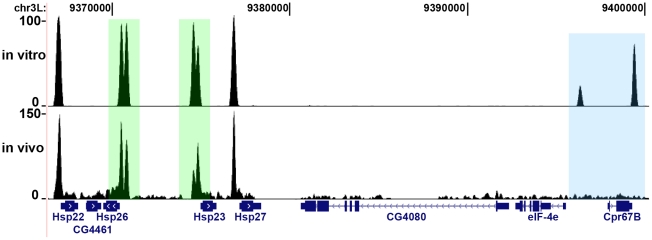
In vitro binding reveals potential HSF binding sites.The blue box highlights strong differences in the usage of potential binding sites in vivo at the Cpr67B locus, while the green boxes highlight differences in the magnitude of binding to major heat shock genes promoters, despite comparable in vitro binding affinities.